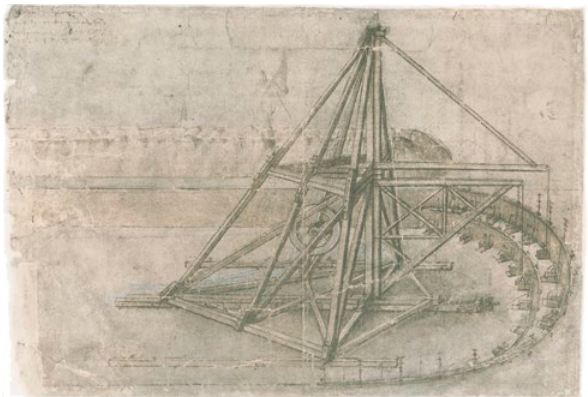
Figure 30. C.A., fol. 4r: Earthmoving